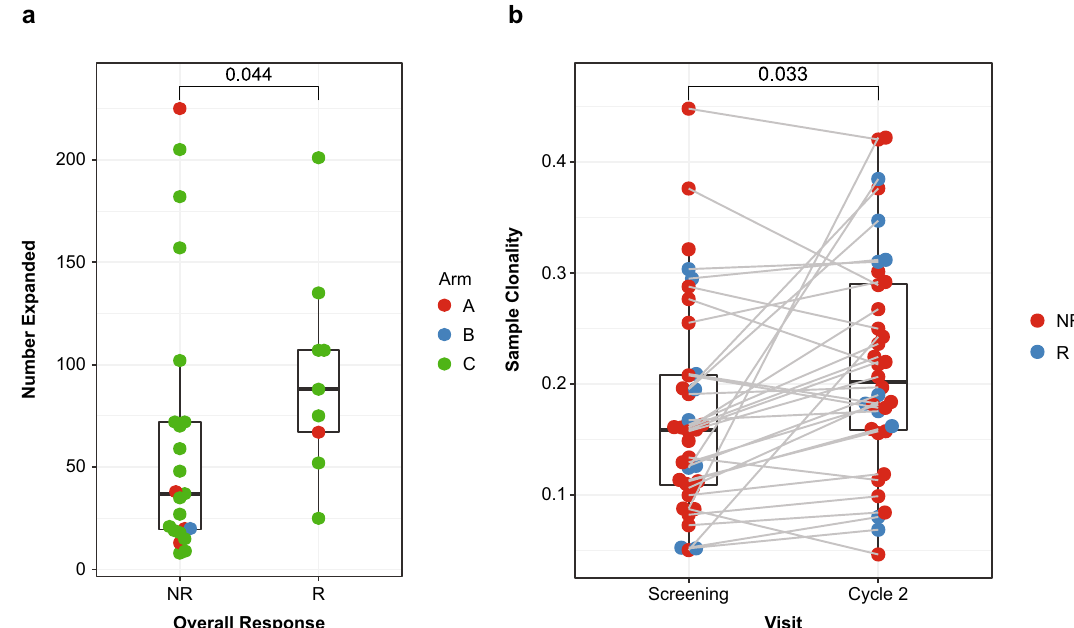
Figure 6. TCR clone expansion and clonality. ( a ) Quantification of the number of expanded clones in patient samples for 9 responders (R) and 23 nonresponders (NR). Each point is a patient, and the y-axis shows the number of T-cell clones that significantly expanded from screening to C2D15 sample collection in the BMMCs. ( b ) Clonality of templates at screening and C2D15 in combined responders and nonresponders. Gray lines connect patients who have both a screening and cycle 2 sample (n = 33). There are 36 samples at screening and 36 samples at cycle 2. For both ( a ) and ( b ), the P value is from a Wilcoxon rank test of the samples in the two groups, where the patient pairing is ignored for ( b ). BMMC, bone marrow mononuclear cells; C2D15, cycle 2 day 15; TCR T-cell